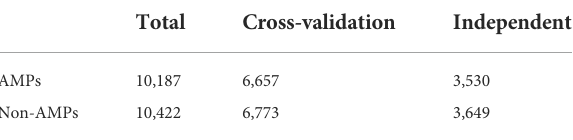
TABLE 1 Statistics for datasets.